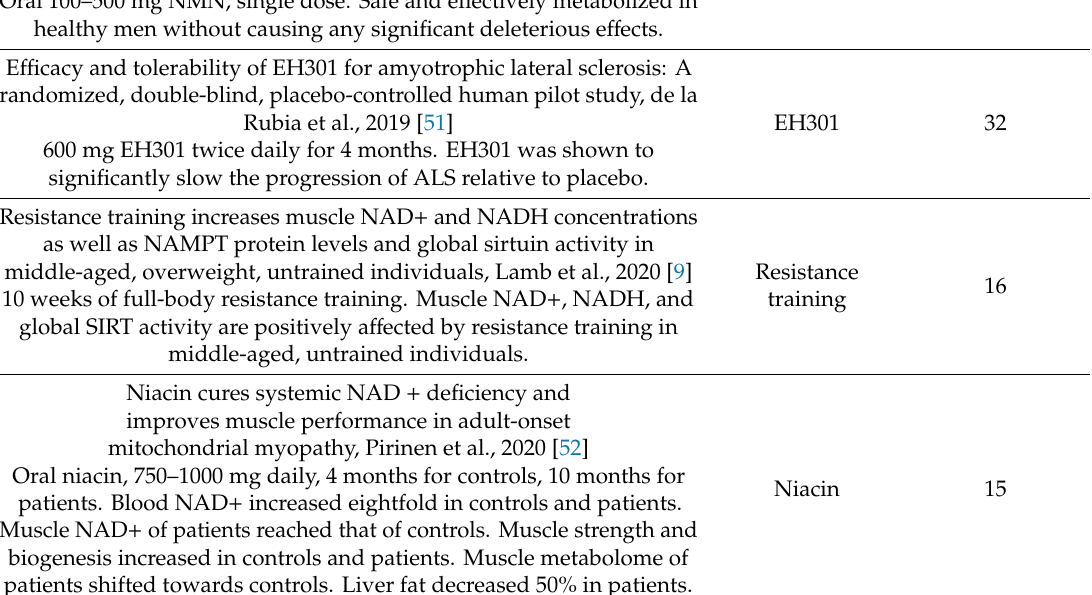
E ffi cacy and tolerability of EH301 for amyotrophic lateral sclerosis: A randomized, double-blind, placebo-controlled human pilot study, de